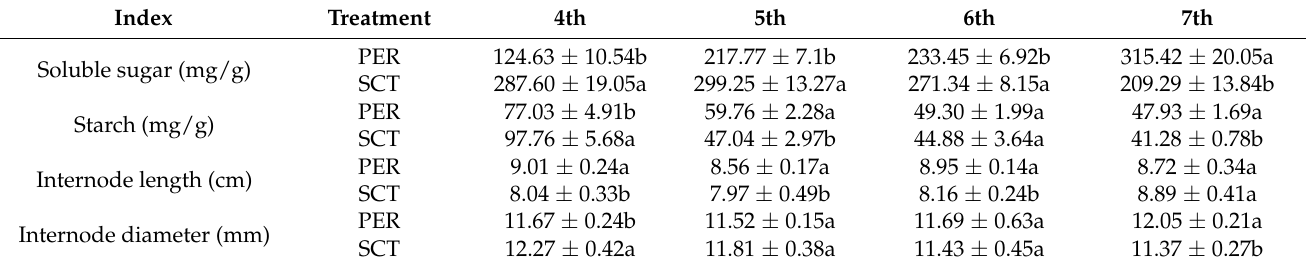
Table 3. Soluble sugar content, starch content, internode length, and diameter of canes with PER (pergola) and SCT (single-curtain training